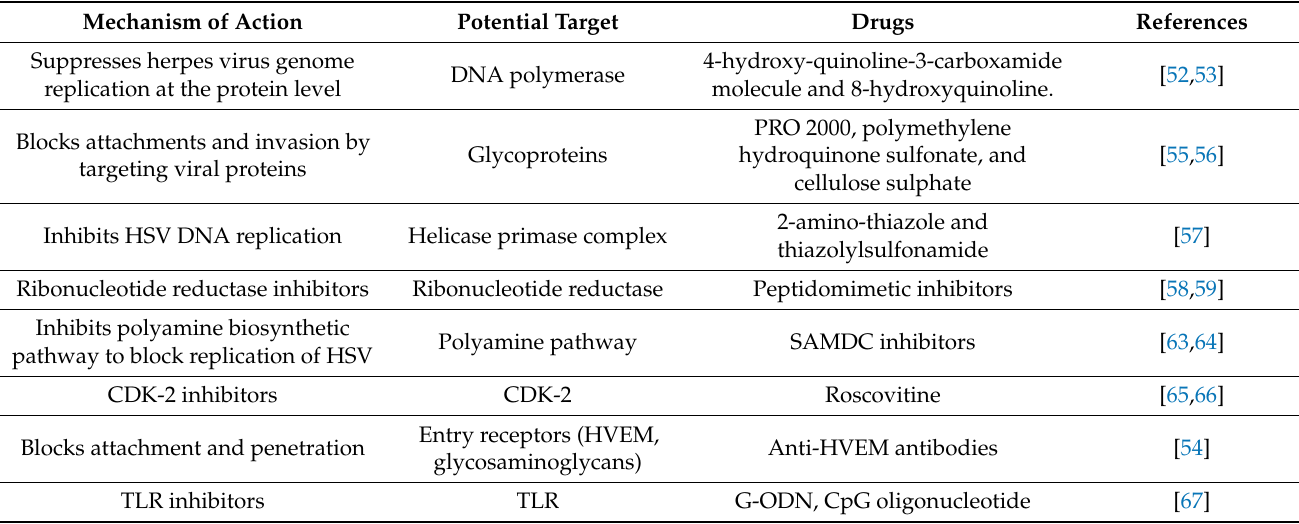
Table 1. Potential targets for HSV